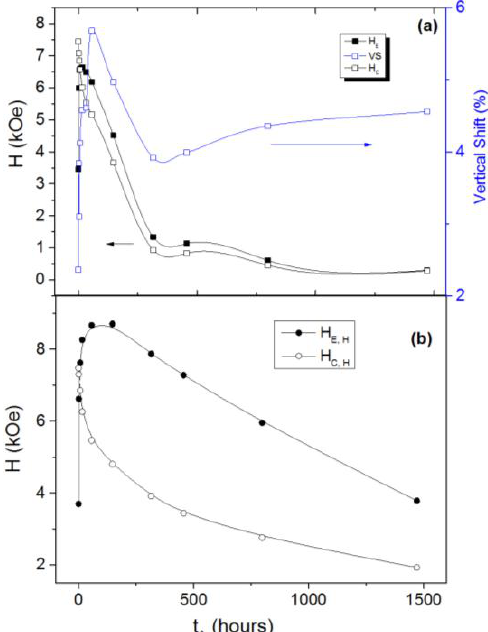
Figure 2. Annealing time dependence of the exchange bias and coercive fields, extracted from both the as-measured loops (upper panel, Figure 2a) and of the hard component extracted from the fits as exemplified in Figure 1b (lower panel, Figure 2b), as well as of the vertical shift (blue squares). The lines are guides for the eye.